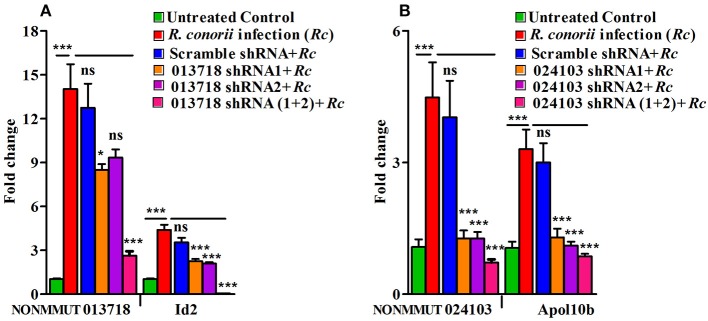
shRNA mediated knock-down of elncRNAs and its target genes during rickettsial infection. Endogenous mRNA expression of Id2 and Apol10b in RAW264.7 macrophages and SVEC endothelial cells after trasfection of NONMMUT013718 shRNA and NONMMUT024103 shRNAs, respectively, following infection with R. conorii for 24 and 3 h, respectively. pLKO.1 scramble plasmid was used as a negative control. Knock-down efficiency of (A) NONMMUT013718 and its target gene Id2; and (B) NONMMUT024103 and its target gene Apol10b were quantified by qPCR. The error bars represented standard error of mean (SEM) and the levels of statistical significance are shown as *P ≤ 0.05; ***P ≤ 0.001; and ns, non-significant.